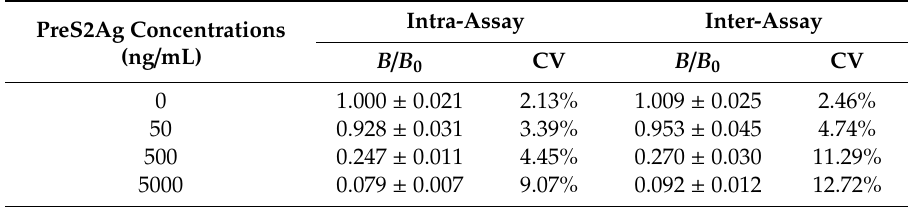
Table 2. Reproducibility evaluation of GAM-MNPs-ICA (n = 6).